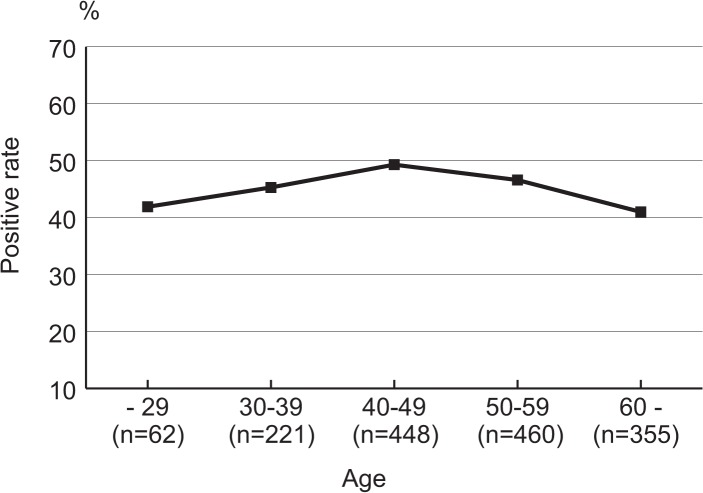
Prevalence of H. pylori infection in Thailand according to the age group.Subjects with positive histology and immunohistochemistry results were considered positive for H. pylori infection.